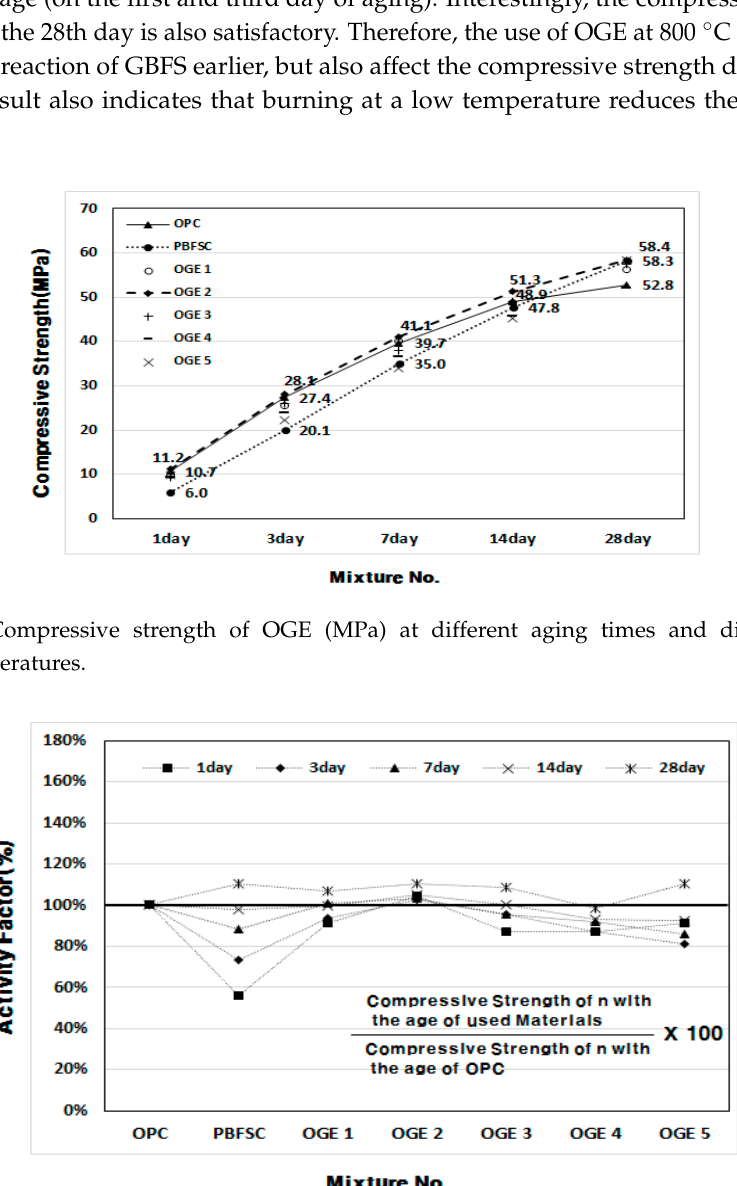
Figure 8. Setting time of OGE at different ESA burning temperatures. 3.3.2. Change in Chemical Composition of ESA and OGE according to Burning Temperature Figures 9 and 10 demonstrate the changes in the chemical composition as a function of the ESA burning temperature and contents of the chemical composition of ESA-mixed OGE. The major components that have a valid effect on early aging are compared in the figures. Among the major chemical components of ESA, the SO 3 content decreases, while the CaO and SiO 2 content increases as the burning temperature increases. Such changes are thought to be attributed to the change in the chemical composition following the decarboxylation of LP and combustion of CO 2 . In comparison with OPC, the SO 3 content in PBFSC is higher by approximately 2%. The SO 3 content in OGE with ESA burnt at different temperatures is also greater by approximately 2% when compared to PBFSC.